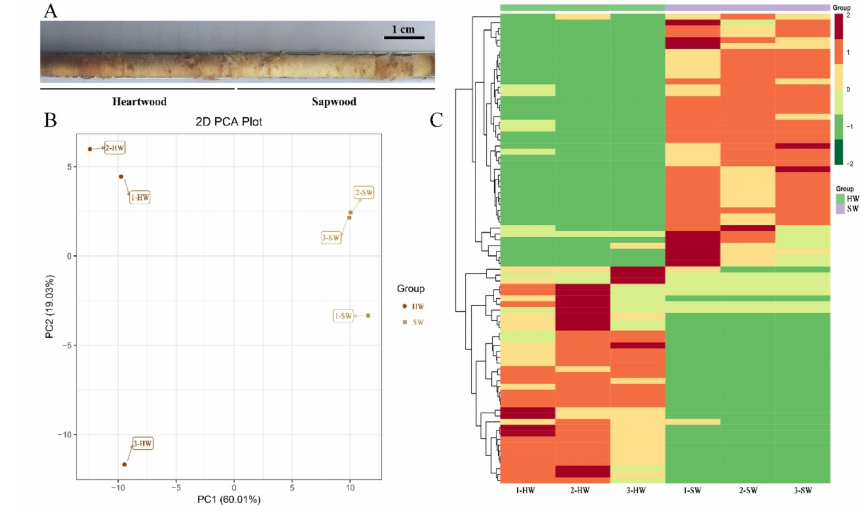
Figure 2. ( A ) A core of red-heart Chinese fir wood, showing red-colored tissue (heartwood, HW) and light-yellow tissue (sapwood, SW). ( B ) PCA score plot of the metabolites in the heartwood and sapwood. ( C ) Heatmap of the metabolites in the heartwood and